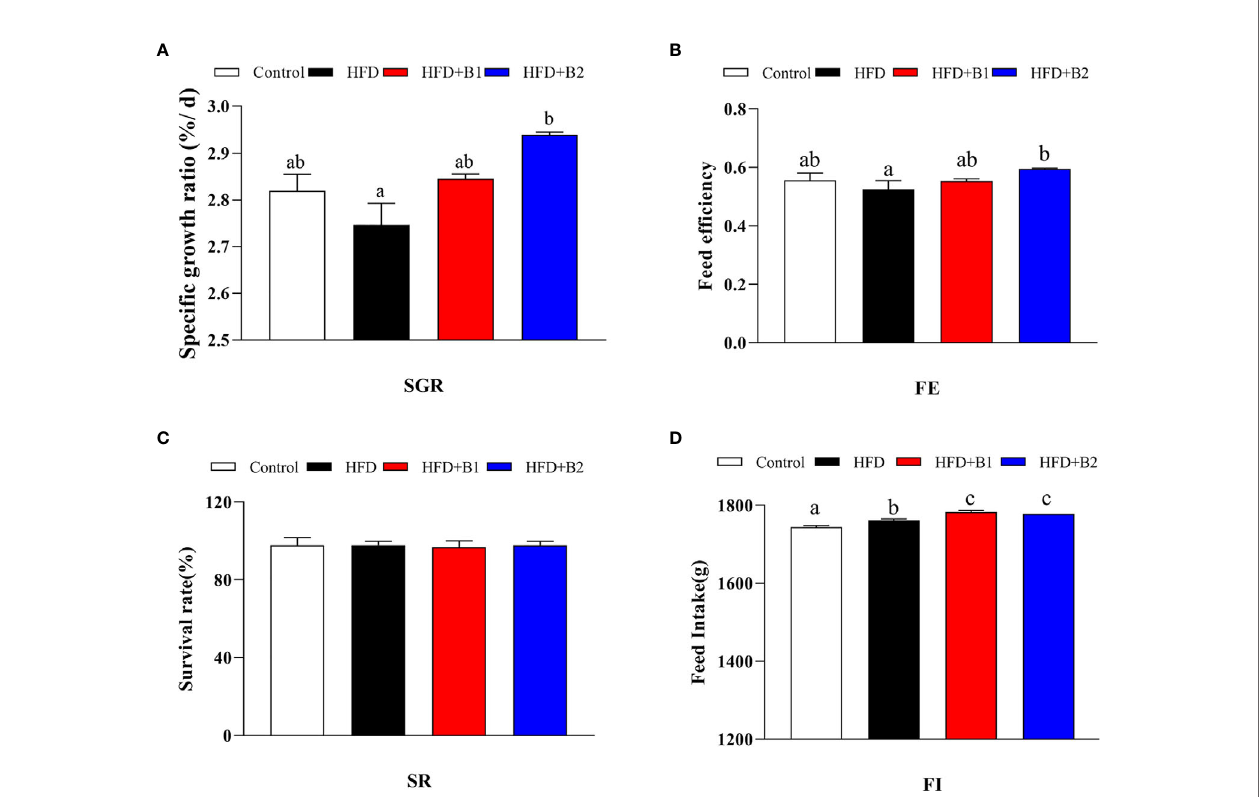
FIGURE 1 | Growth performance and feed utilization of juvenile black seabream ( Acanthopagrus schlegelii ) fed the experimental diets (Control: 11% crude lipid; HFD: high-fat diet; HFD+B1: HFD +betaine (10g/kg); HFD+B2: HFD + betaine (20 g/kg)) for 8 weeks. (A) Speci fi c growth ratio (SGR): SGR (%/d) = 100 × (Ln ( fi nal body weight)- Ln (initial body weight))/56 days. (B) Feed ef fi ciency (FE): FE = weight gain (g, wet weight)/feed consumed (g, dry weight). (C) Survival rate (SR): SR (%) = 100 ( fi nal fi sh number/initial fi sh number). (D) Total dry feed intake (FI) (during the feeding trial of 8 week). Values are means (n=3) with standard errors represented by vertical bars. Mean values for the same column with different letters were signi fi cantly different ( P <